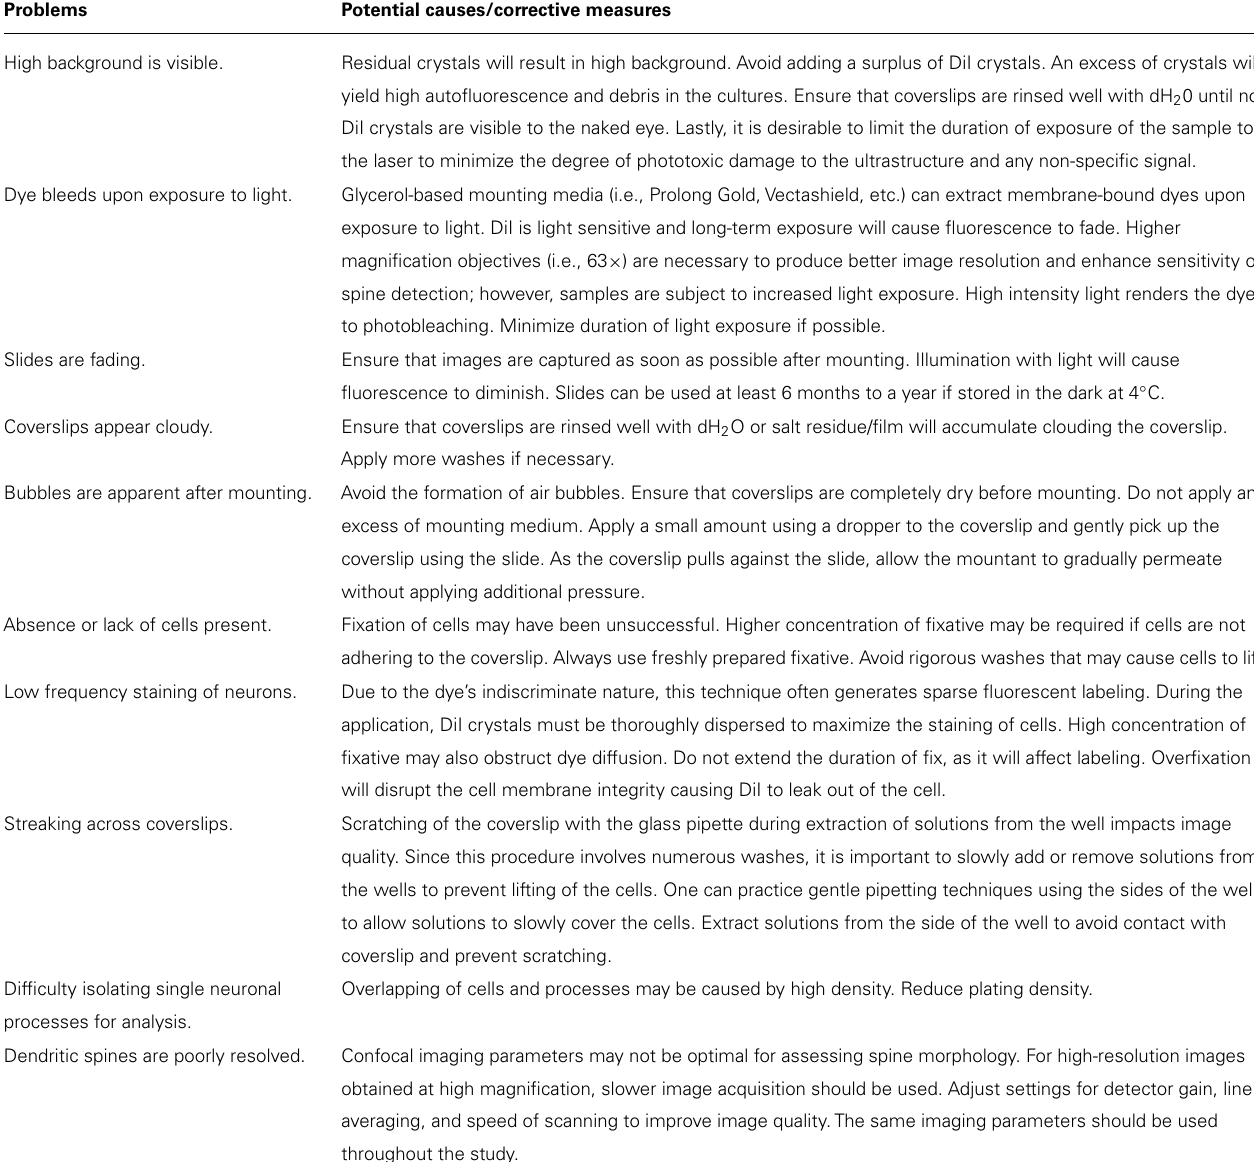
Table 1 |Troubleshooting guide for optimal DiI labeling. Problems Potential causes/corrective